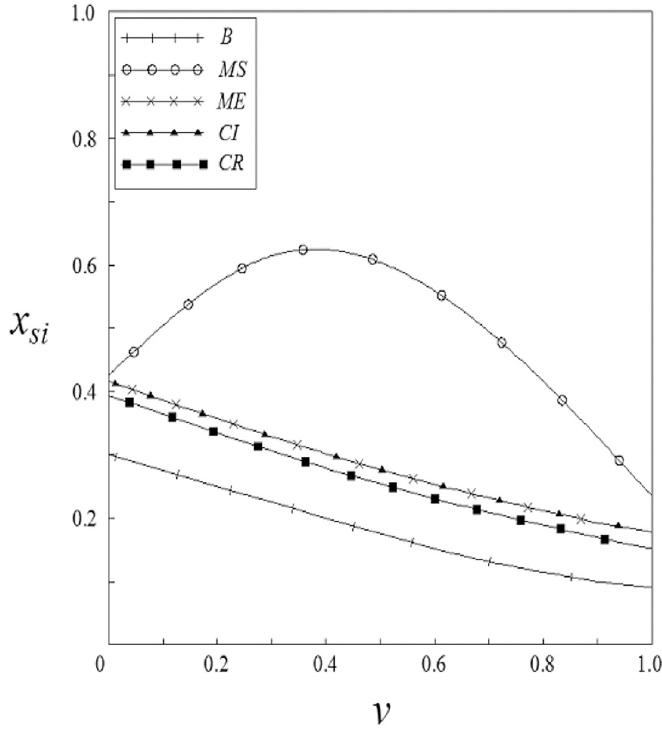
Fig 1. The relationship between x si and ν .